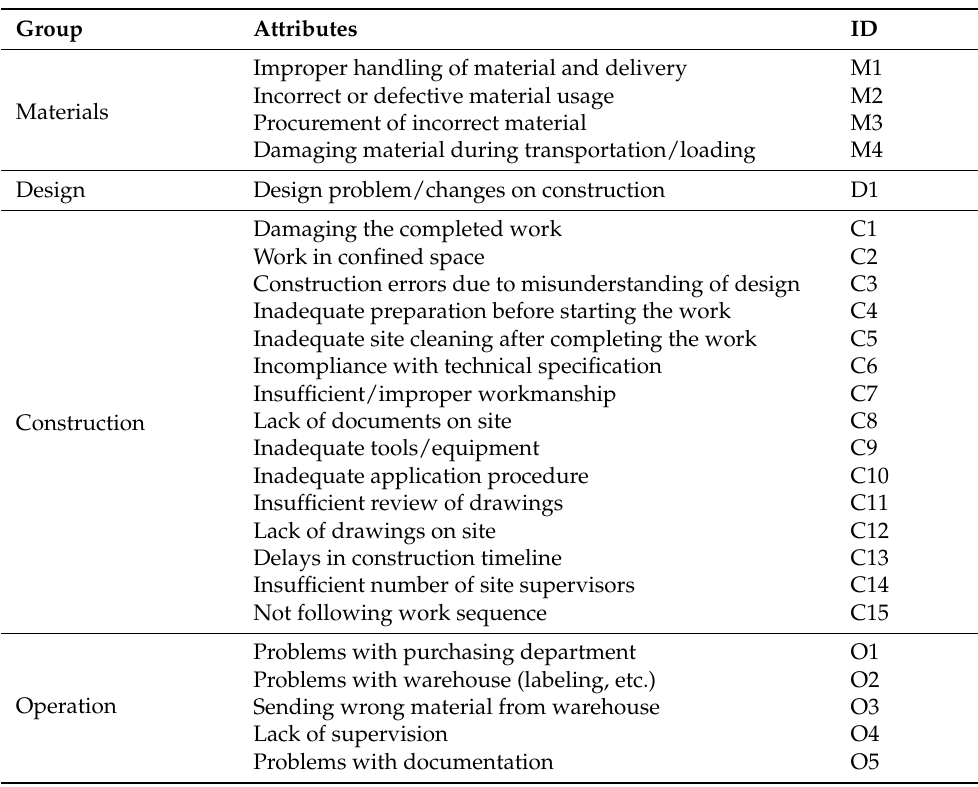
Table 4. List of final rework attributes used in the study